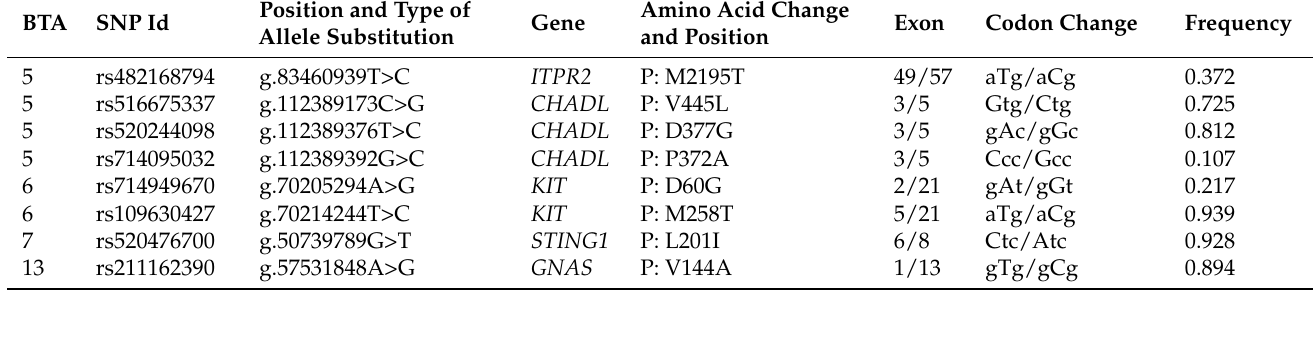
Table 6. Examples of missense SNPs and their frequencies in Ethiopian cattle populations.